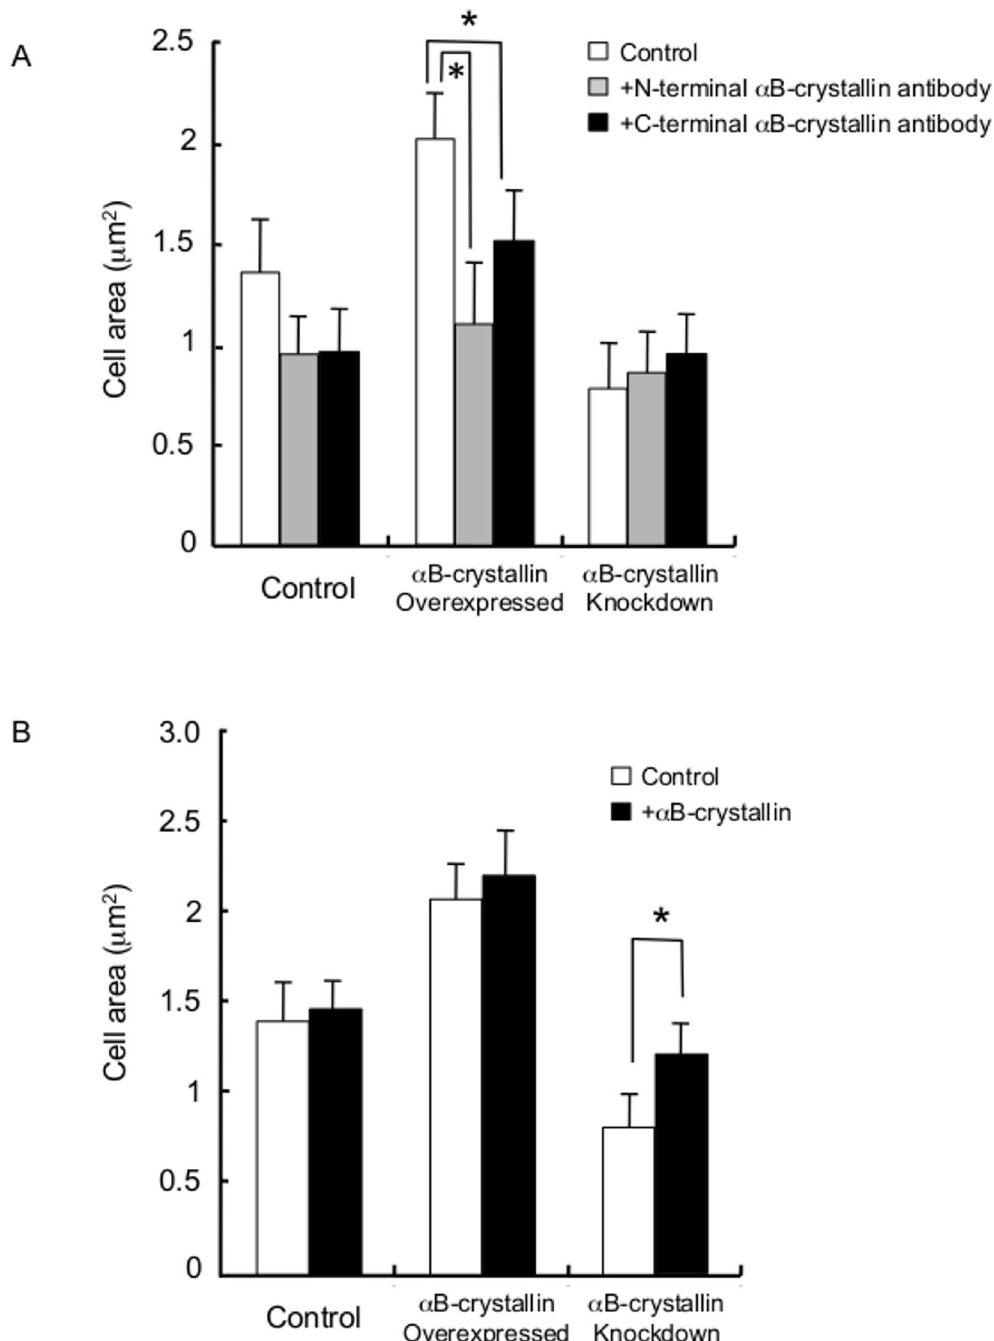
Fig 2. Cell morphology and α B-crystallin level. (A) Characteristic cell morphology is specific to α B-crystallin level as revealedby inhibitoryantibody injectionand (B) injectionof purifiedbovine lens protein α B-crystallin into wild-type, α B-crystallin-overexpressing and knockdown C6 cells. Asterisk indicatesP value of <